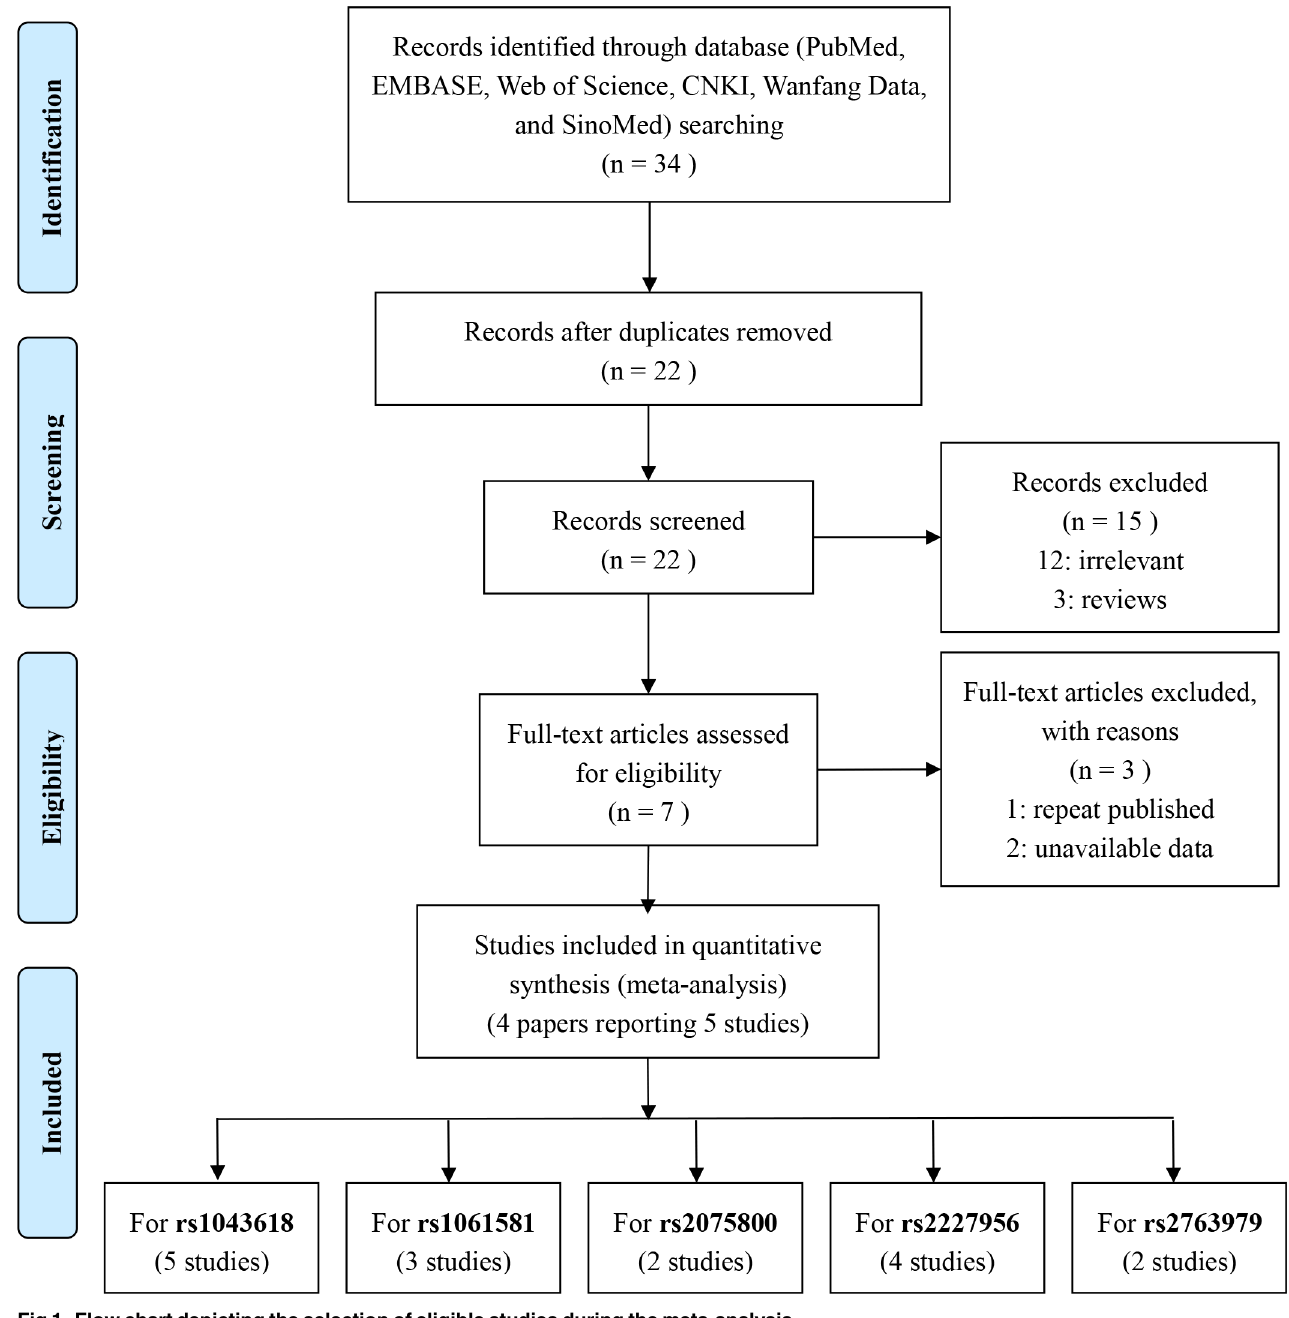
Fig 1. Flow chart depicting the selection of eligible studies during the meta-analysis.